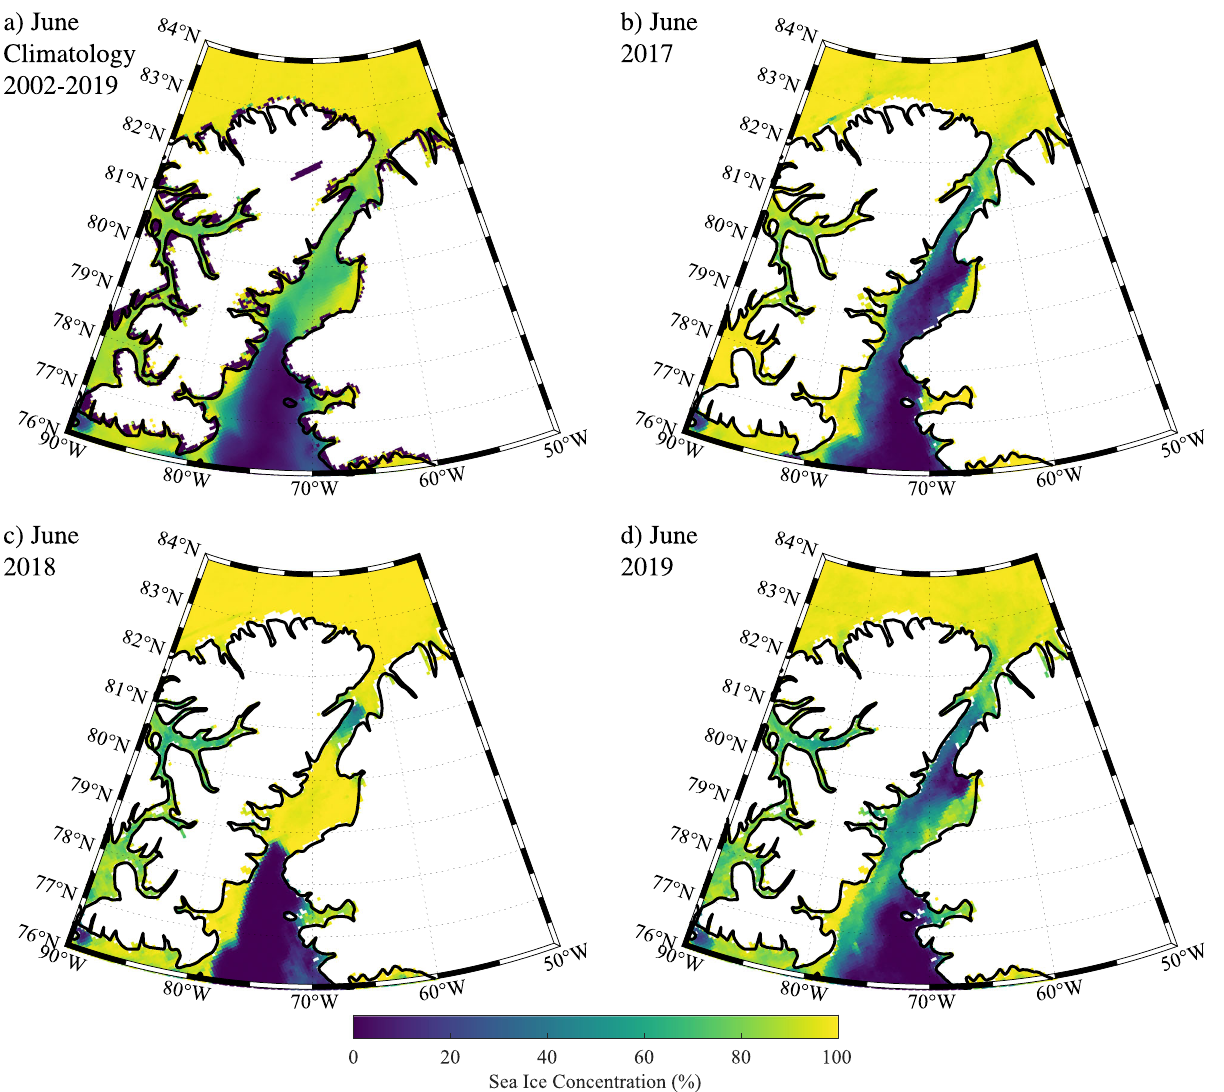
Fig. 6 Sea ice concentration (%) along Nares Strait from AMSRE/2 satellite data during June. a climatology 2002 – 2019; b 2017; c 2018, and d